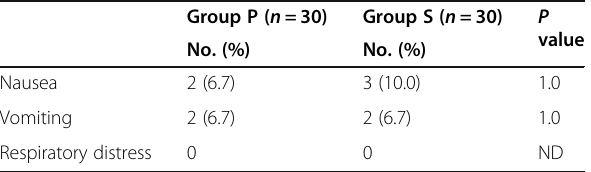
Table 3 Side effects in both groups